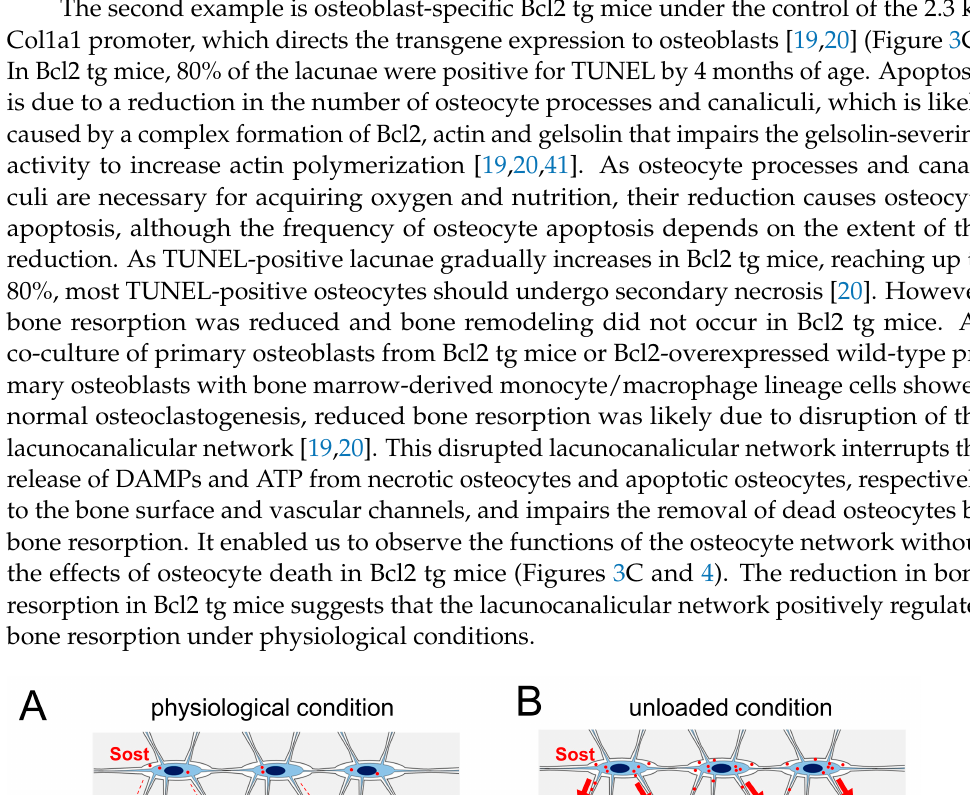
Figure 3. Bcl2 tg and Sp7 tg mice under physiological and unloaded conditions: In Bcl2 tg mice, the osteocyte network is disrupted by osteocyte apoptosis and their secondary necrosis due to reduced osteocyte processes and canaliculi ( A , C ). Sost is expressed in live osteocytes but cannot be released to the bone surface due to the interrupted lacunocanalicular network ( C ). Bone formation is in- creased, but bone resorption is decreased, and trabecular and cortical bone is increased in Bcl2 tg mice under physiological conditions ( A , C ). Sp7 tg mice have reduced osteocyte processes and canaliculi and 14% of osteocytes are TUNEL-positive ( A , E ). The lacunocanalicular network is functionally connected and secreted Sost reaches the bone surface ( E ). DAMPs from necrotic oste- ocytes, and ATP from apoptotic osteocytes are also likely to reach the bone surface and enhance bone resorption ( E ). Although bone formation in Sp7 tg mice is similar to that in wild-type mice, bone resorption is increased compared with wild-type mice due to osteocyte death under physio- logical conditions ( A , E ). In unloading, bone formation is reduced and bone resorption is increased, at least partly, through the increase in Sost and Rankl expression in osteocytes and osteoblasts, respectively, and Sost expression is increased in the compression side but not in the tension side of cortical bone in wild-type mice ( A , B ). Bone formation and resorption are unchanged by unloading in Bcl2 tg mice, and Sost expression in osteocytes in the compression and tension sides, and Rankl